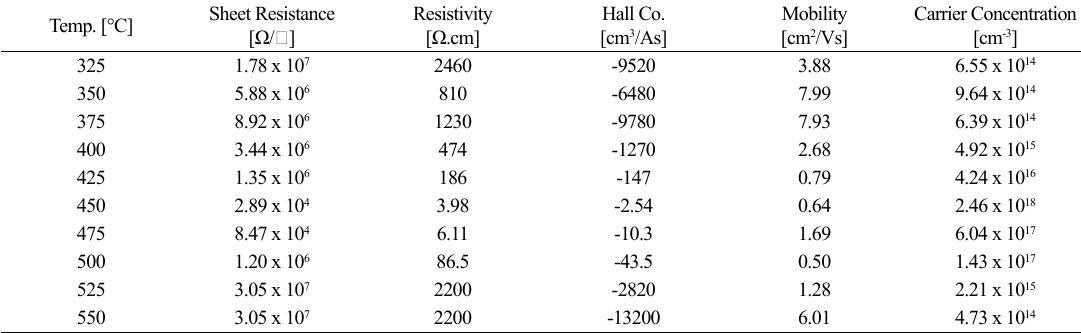
Table 5. Electrical properties of ZnO/Ag bilayers prepared at 450 °C with different Ag thicknesses. Temp. [°C]